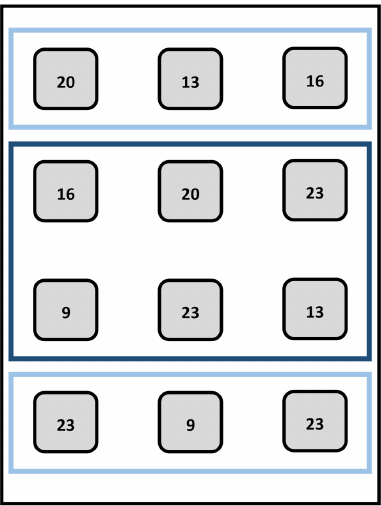
Figure 7. Illustration of the randomization for the plants used for the destructive measurements within the first (light blue square) and second (dark blue square) block (plant location). The numbers exemplarily show the day of the destructive measurements the plants were used